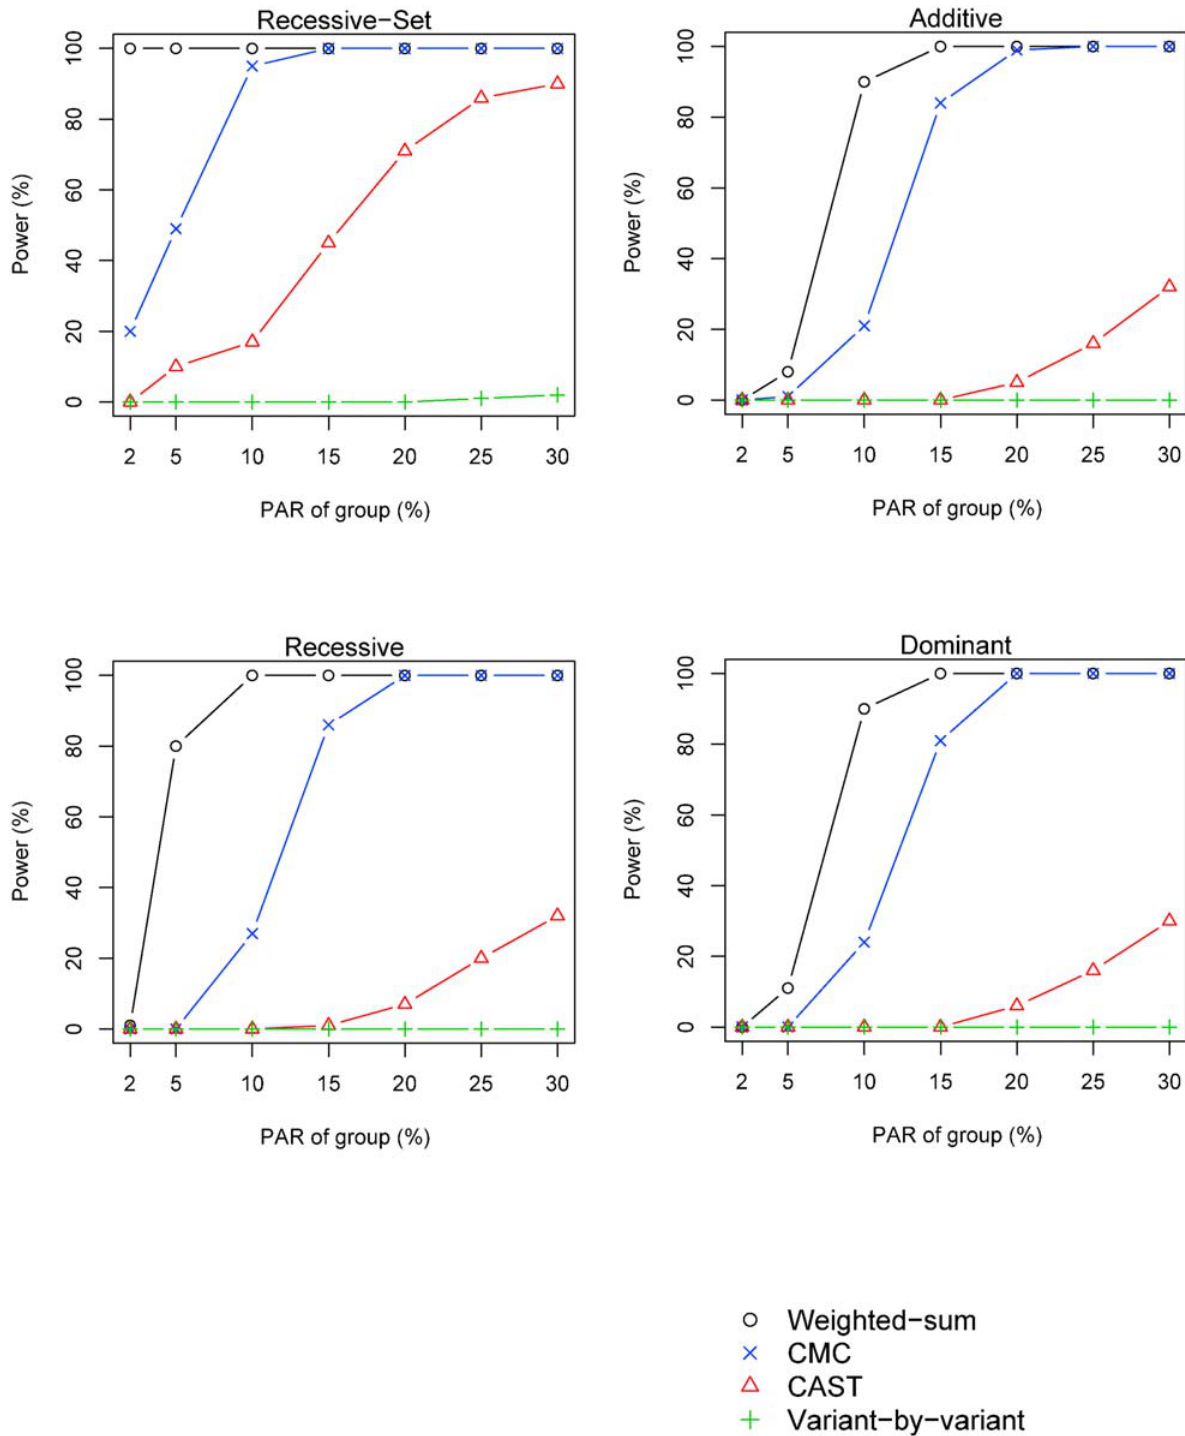
Figure 2. Power versus PAR of group. The power of the investigated methods is shown for different levels of group-PAR. The power simulations were performed using n A = n U =1000 individuals, 50 D-variants, 50 N-variants and p M =10%.